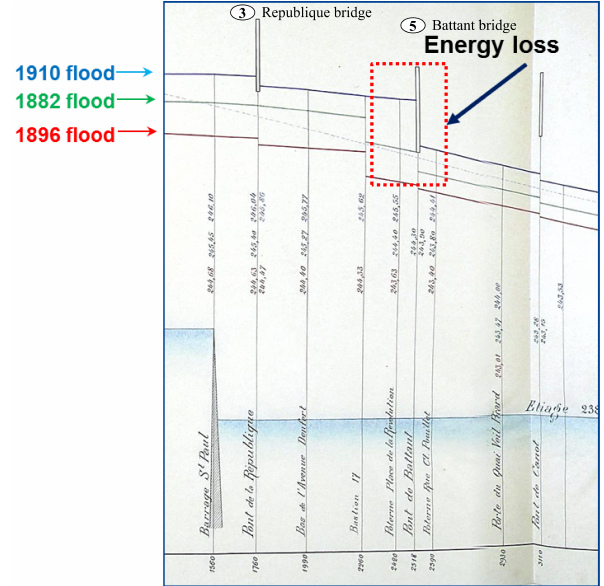
Figure 3. Longitudinal profile of the Doubs River within the old city of Besançon and inter-comparison of floods (sources: Ville de Besançon – Service de la voirie et des eaux: Profil en long des crues du Doubs du 21 janvier 1910, 28 décembre 1882 et 10 mars 1896, 10 mars 1910, Bibliothèque et archives municipales de Besançon, série 0). Locations of the Republique and Battant bridges are shown in Fig.